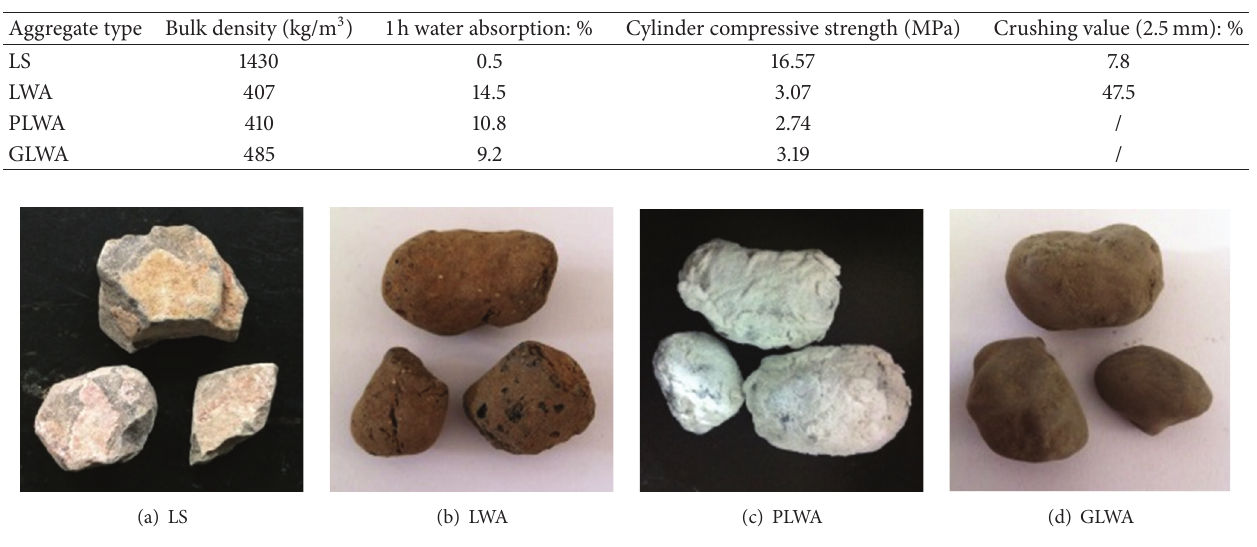
Figure 1: Different types of coarse